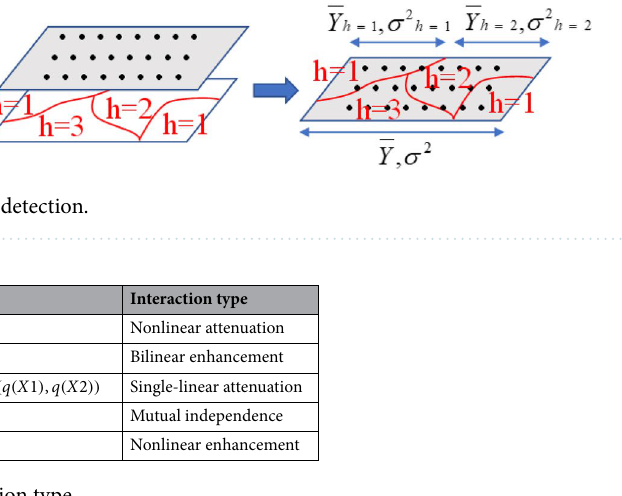
Table 5. Classification of interaction type.